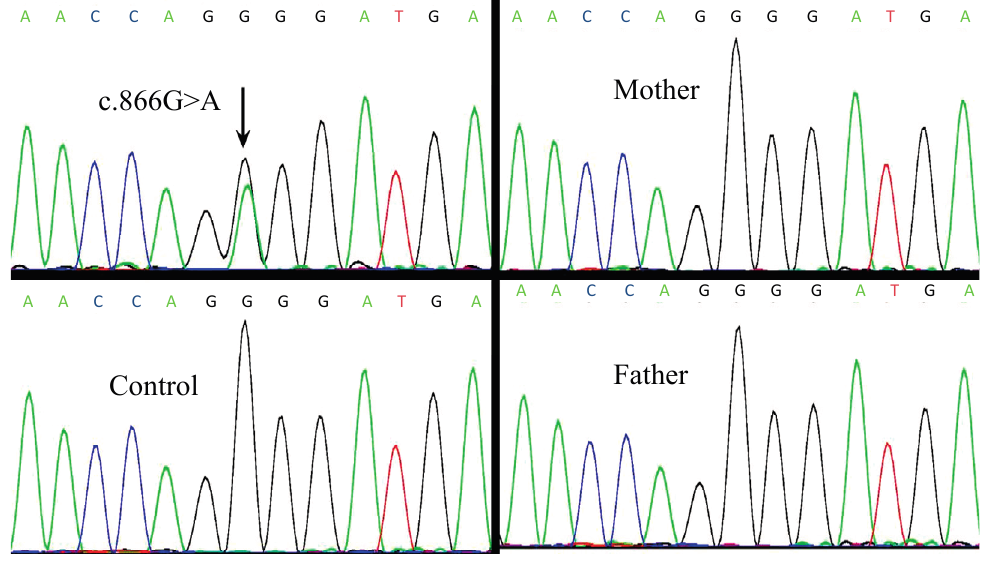
Figure 2. Automated sequencing traces for PRKAR1A gene mutations. ( A) Sequencing trace for the patient shows a heterozygous c.866G>A mutation; ( B – D) Control and the patient’s parents sequencing traces show no abnormalities at the same